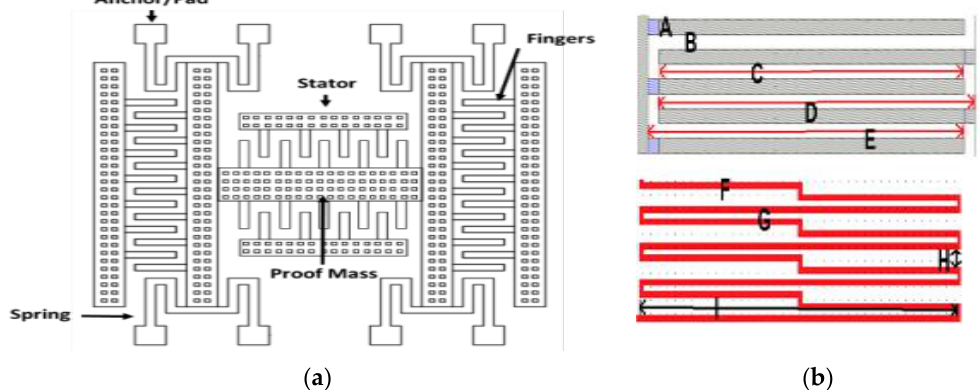
Figure 1. ( a ) Model of microelectromechanical (MEMS) magnetometer; ( b ) marks on combs and springs of the structure. Table 1. Sizes of MEMS magnetometer.